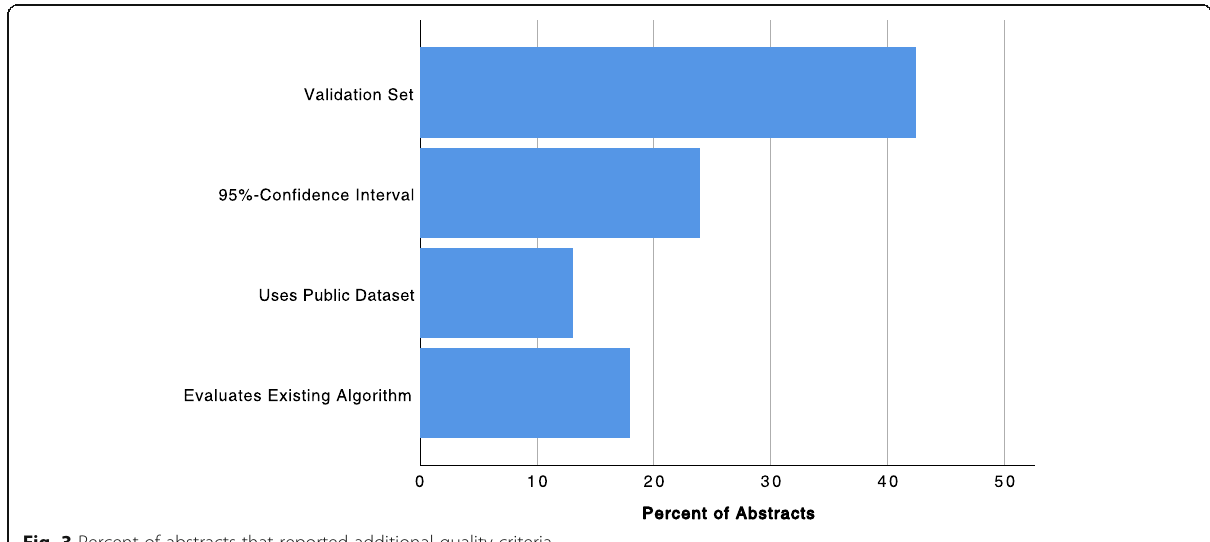
Fig. 3 Percent of abstracts that reported additional quality